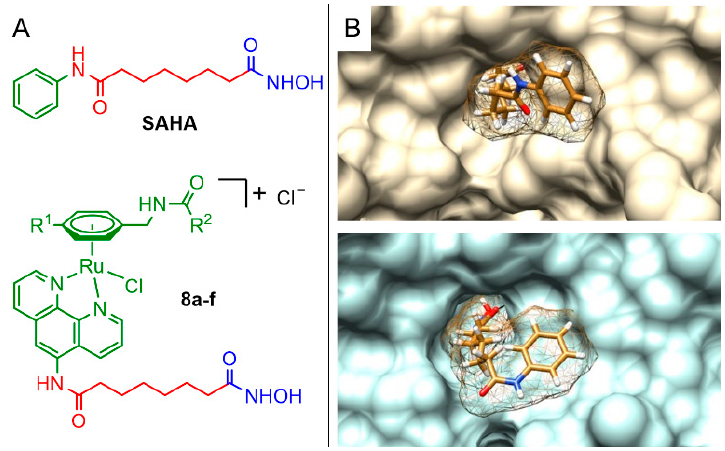
Figure 1. A : HDAC pan inhibitor SAHA and Ru complexes 8a – f , described in this work. B : Docking Figure 1. ( A ) HDAC pan inhibitor SAHA and Ru complexes 8a – f , described in this work. ( B ) Docking models of SAHA with isoforms HDAC1 (upper) and HDAC6 (lower), showing the differences in models of SAHA with isoforms HDAC1 (upper) and HDAC6 (lower), showing the di ff erences in active active site cavity entrances. site cavity